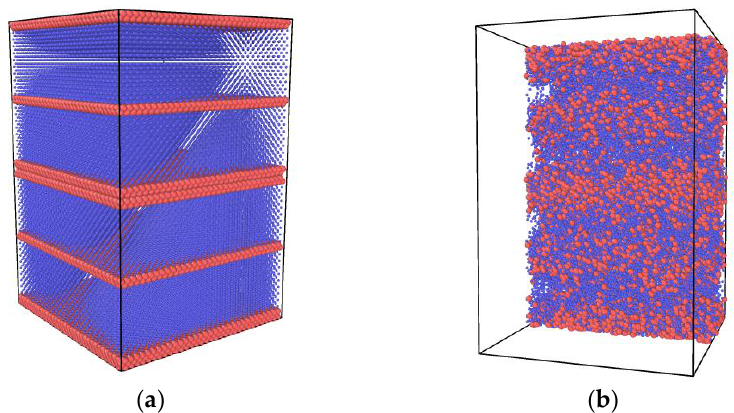
Figure 9. A new sandwich molecular dynamics model: ( a ) Initial system distribution; ( b ) well- proportioned system.